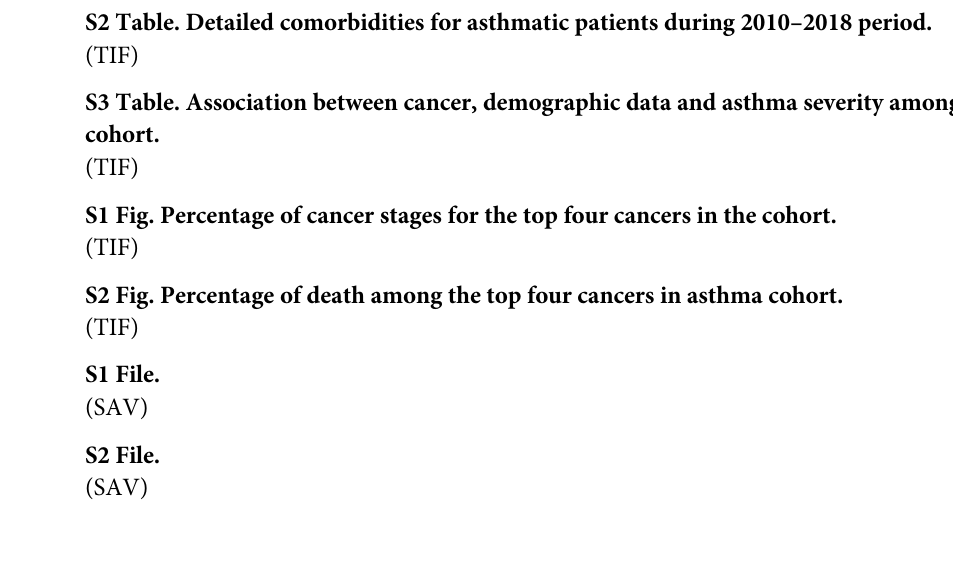
S1 Table. GINA guidelines step-up medications. S2 Table. Detailed comorbidities for asthmatic patients during 2010–2018 period. S3 Table. Association between cancer, demographic data and asthma severity among the cohort. S1 Fig. Percentage of cancer stages for the top four cancers in the cohort. S2 Fig. Percentage of death among the top four cancers in asthma